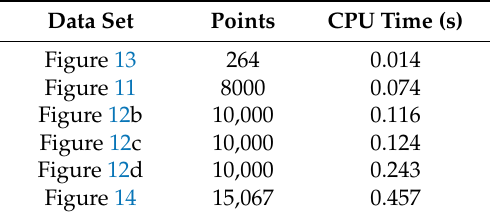
Table 2. CPU time (s) spent for clustering.